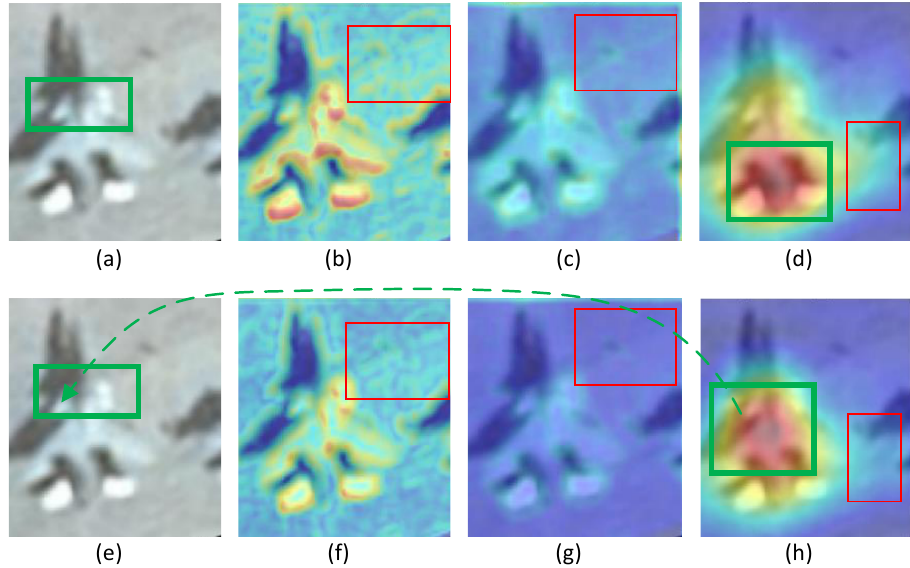
Figure 10. Heatmaps of aircraft Type41 before and after adding a non-locally enhanced